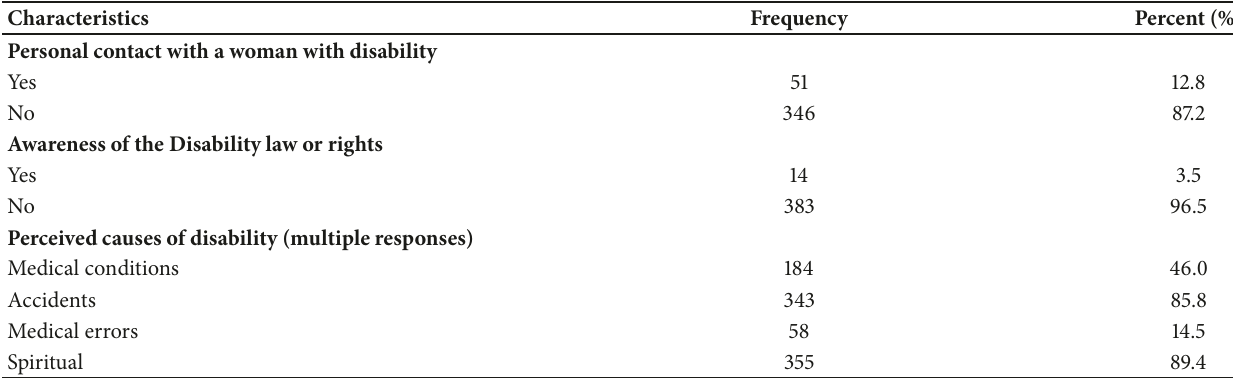
Table 2: Participants knowledge about